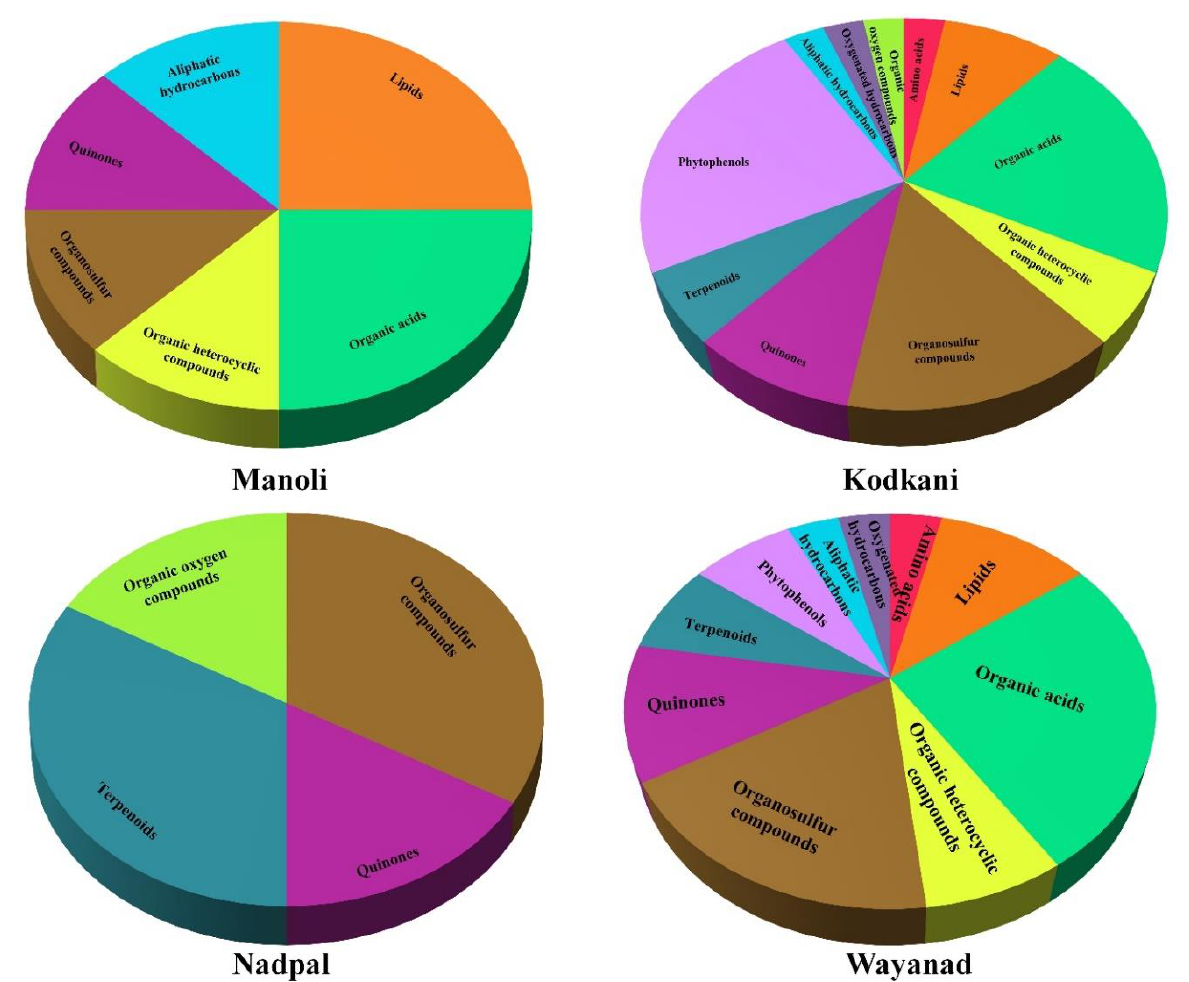
Figure 4. Distribution of chemical classes across the accessions . Identified compounds were grouped according to their compound classes. A total of 11 classes of compounds were found. Kodkani accession showed all 11 groups, followed by ten groups in Wayand, six in Manoli, and four in in Nadpal.